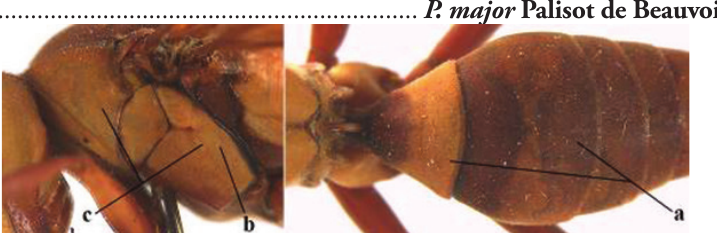
– Body black with yellow pattern (aa); mesopleuron with dense irregular micro- striae (bb, cc) (subgenus Polistes ) .................................................................